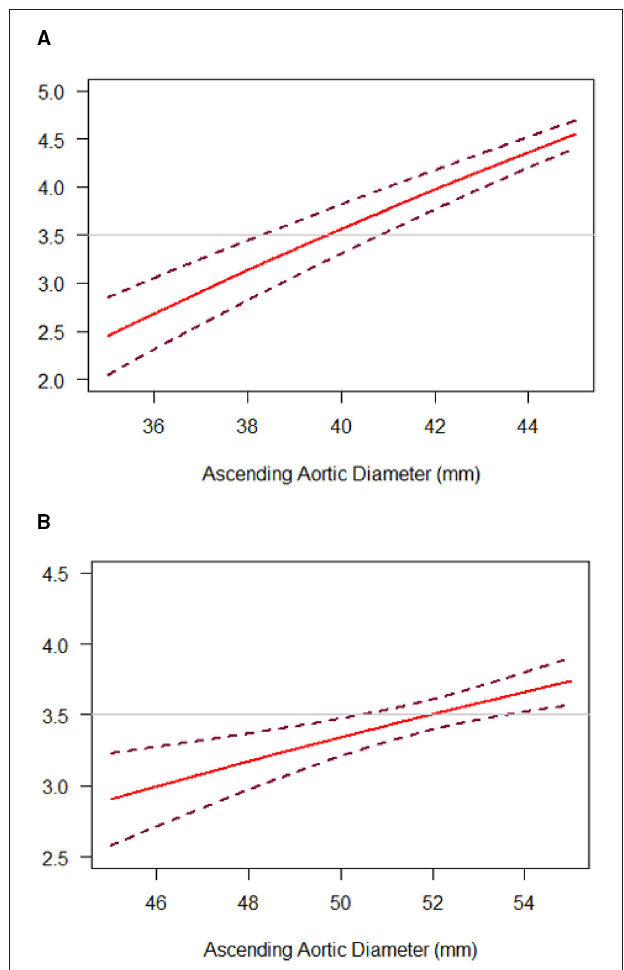
FIGURE 4 | Diameter-dependent hazard of death and reoperation with IR, as compared with PR, in the “Valve Type” (A) or “Aorta Type” (B) groups. The hazard ratio (HR) for death and reoperation with IR, as compared with PR, was plotted against ascending aortic diameter as a continuous variable (solid lines). Dashed lines representing the 95% CI were obtained from bootstrap resampling. The horizontal line at 3.5 was consistent with reported